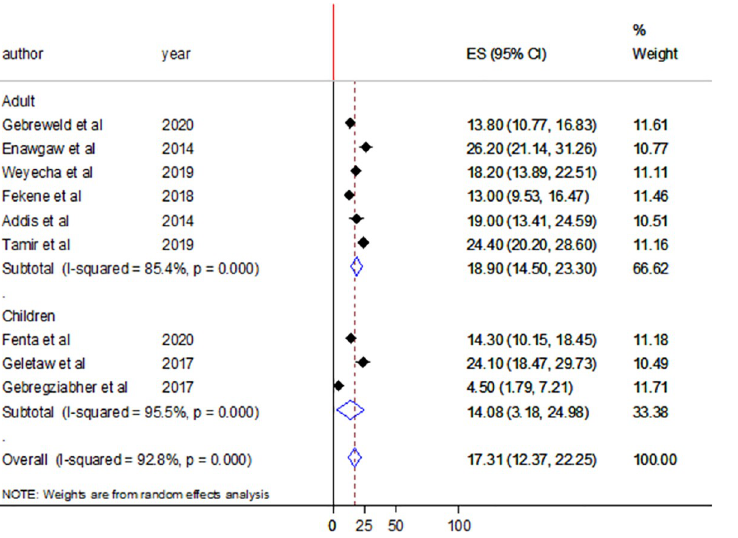
Fig 9. Forest plot showing the pooled prevalence of leucopenia by study groups.